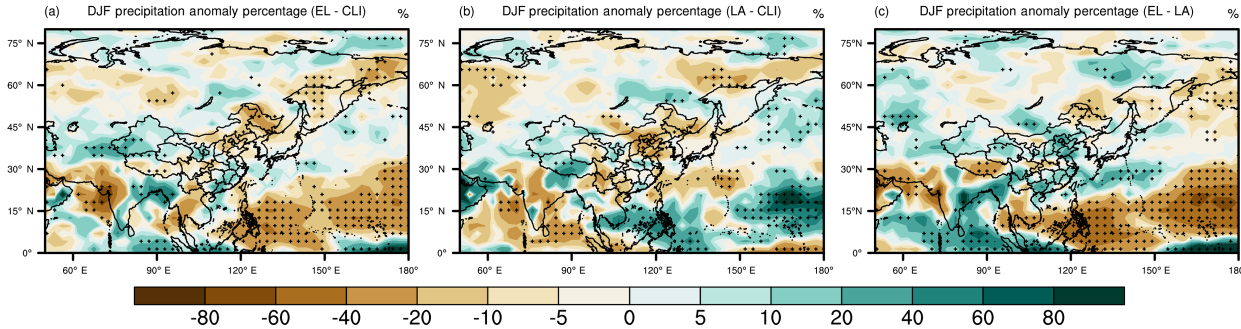
Figure 8. Medians of the simulated differences in winter-average precipitation in percentage (%) between (a) EL and CLI, (b) LA and CLI, and (c) EL and LA, with black dots indicating that the differences between more than 70% of ensemble member pairs have the same sign as the median